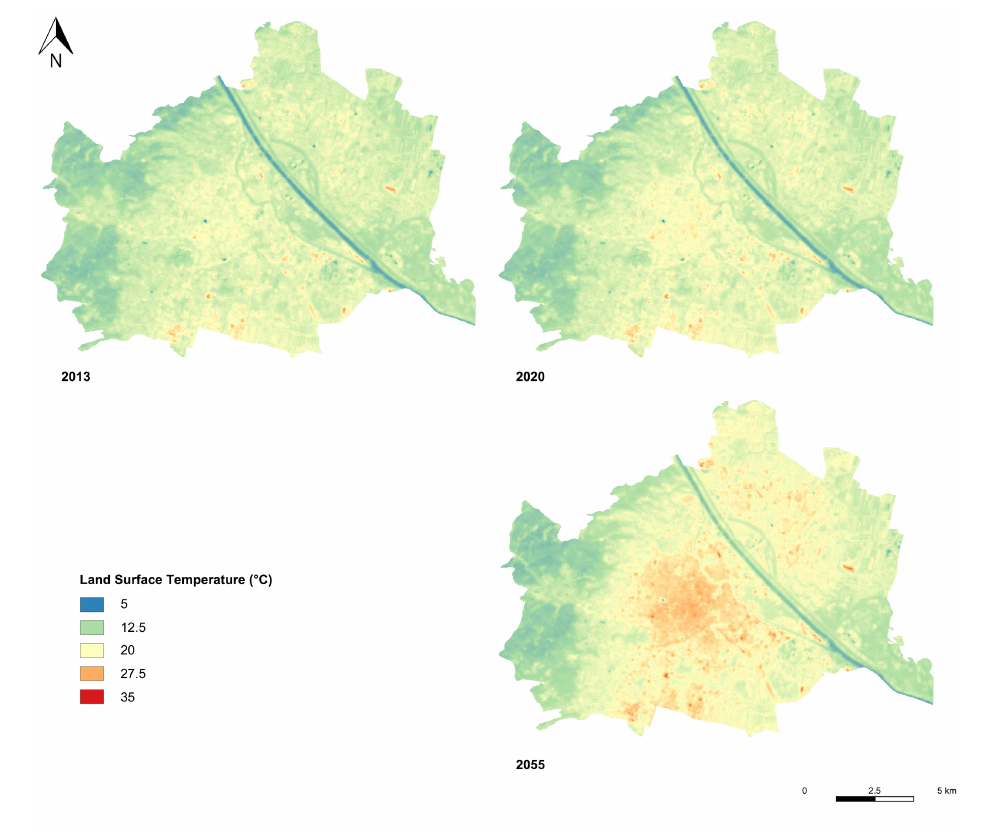
Figure 2. Land surface temperatures in